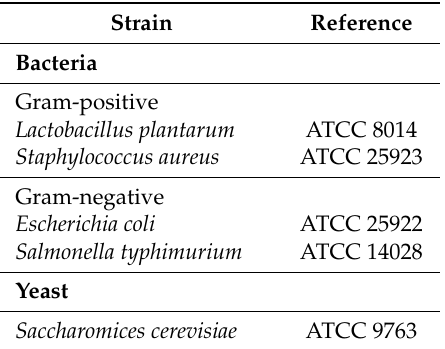
Table 1. List of strains of tested